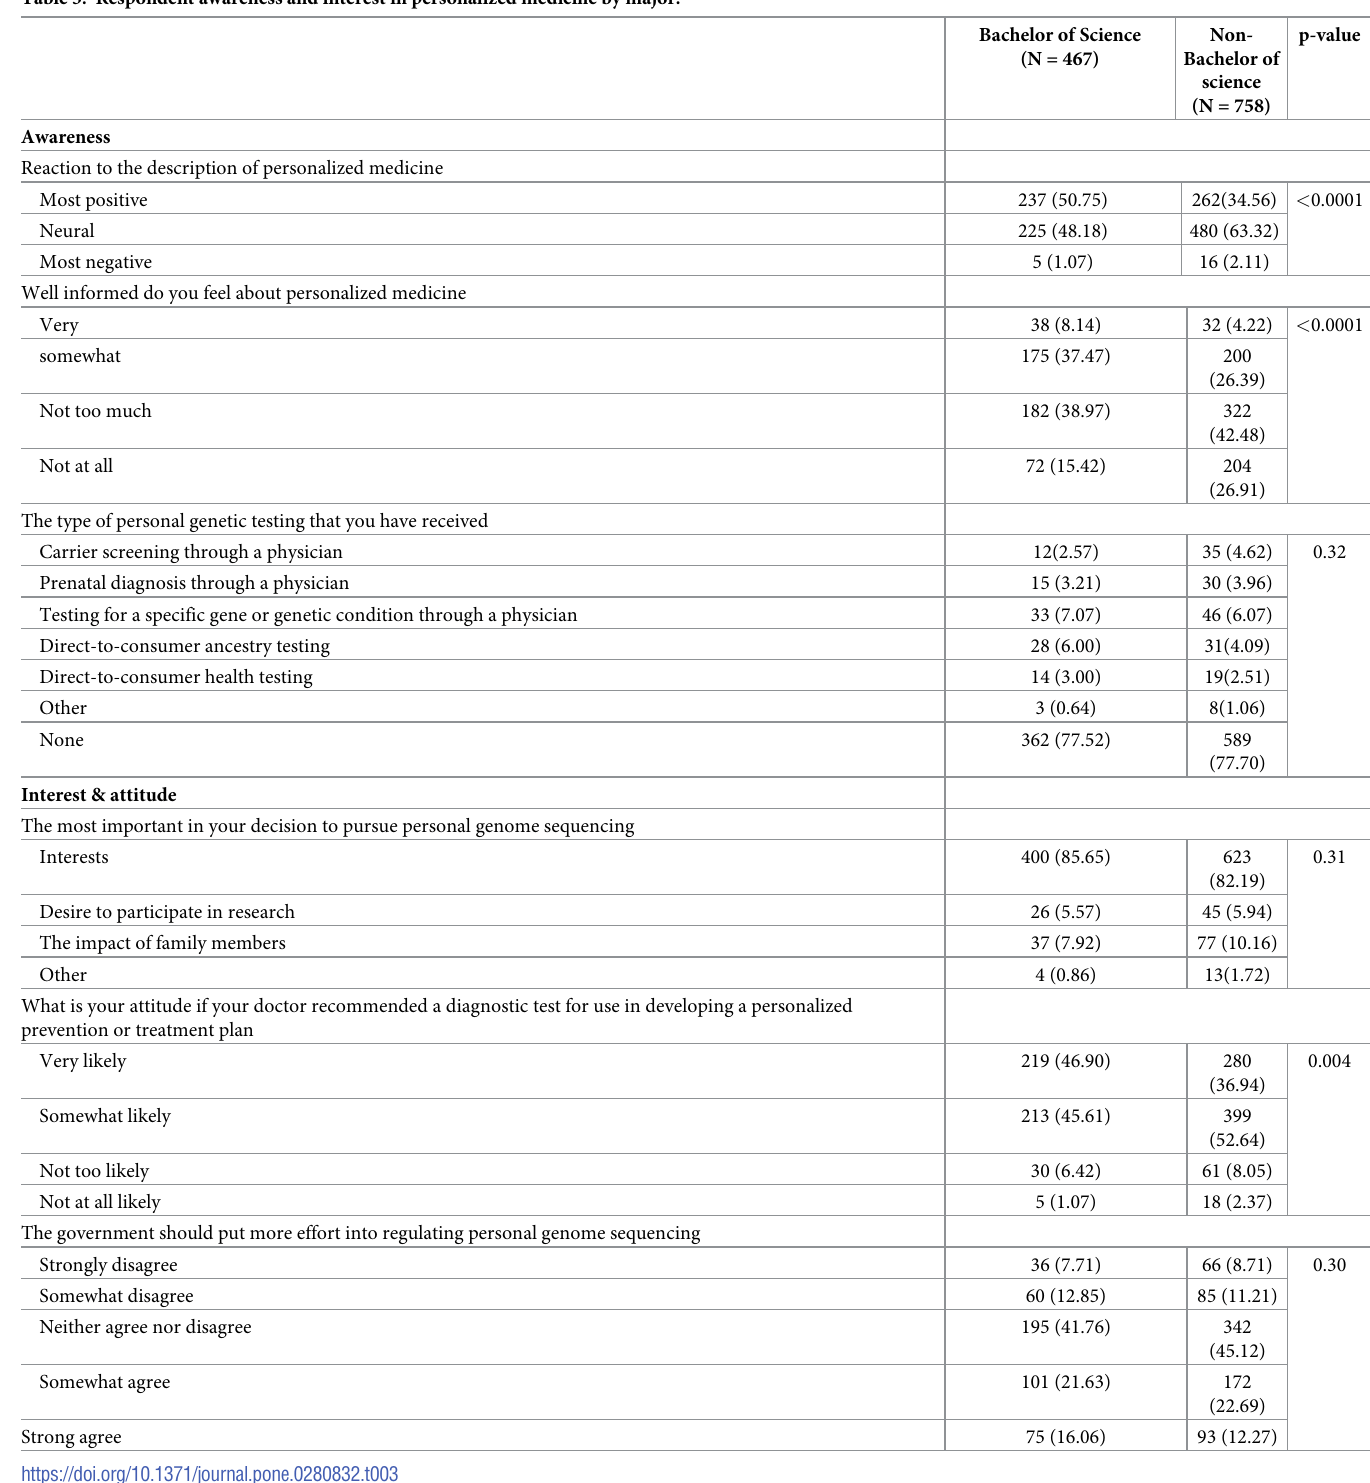
Table 3. Respondent awareness and interest in personalized medicine by